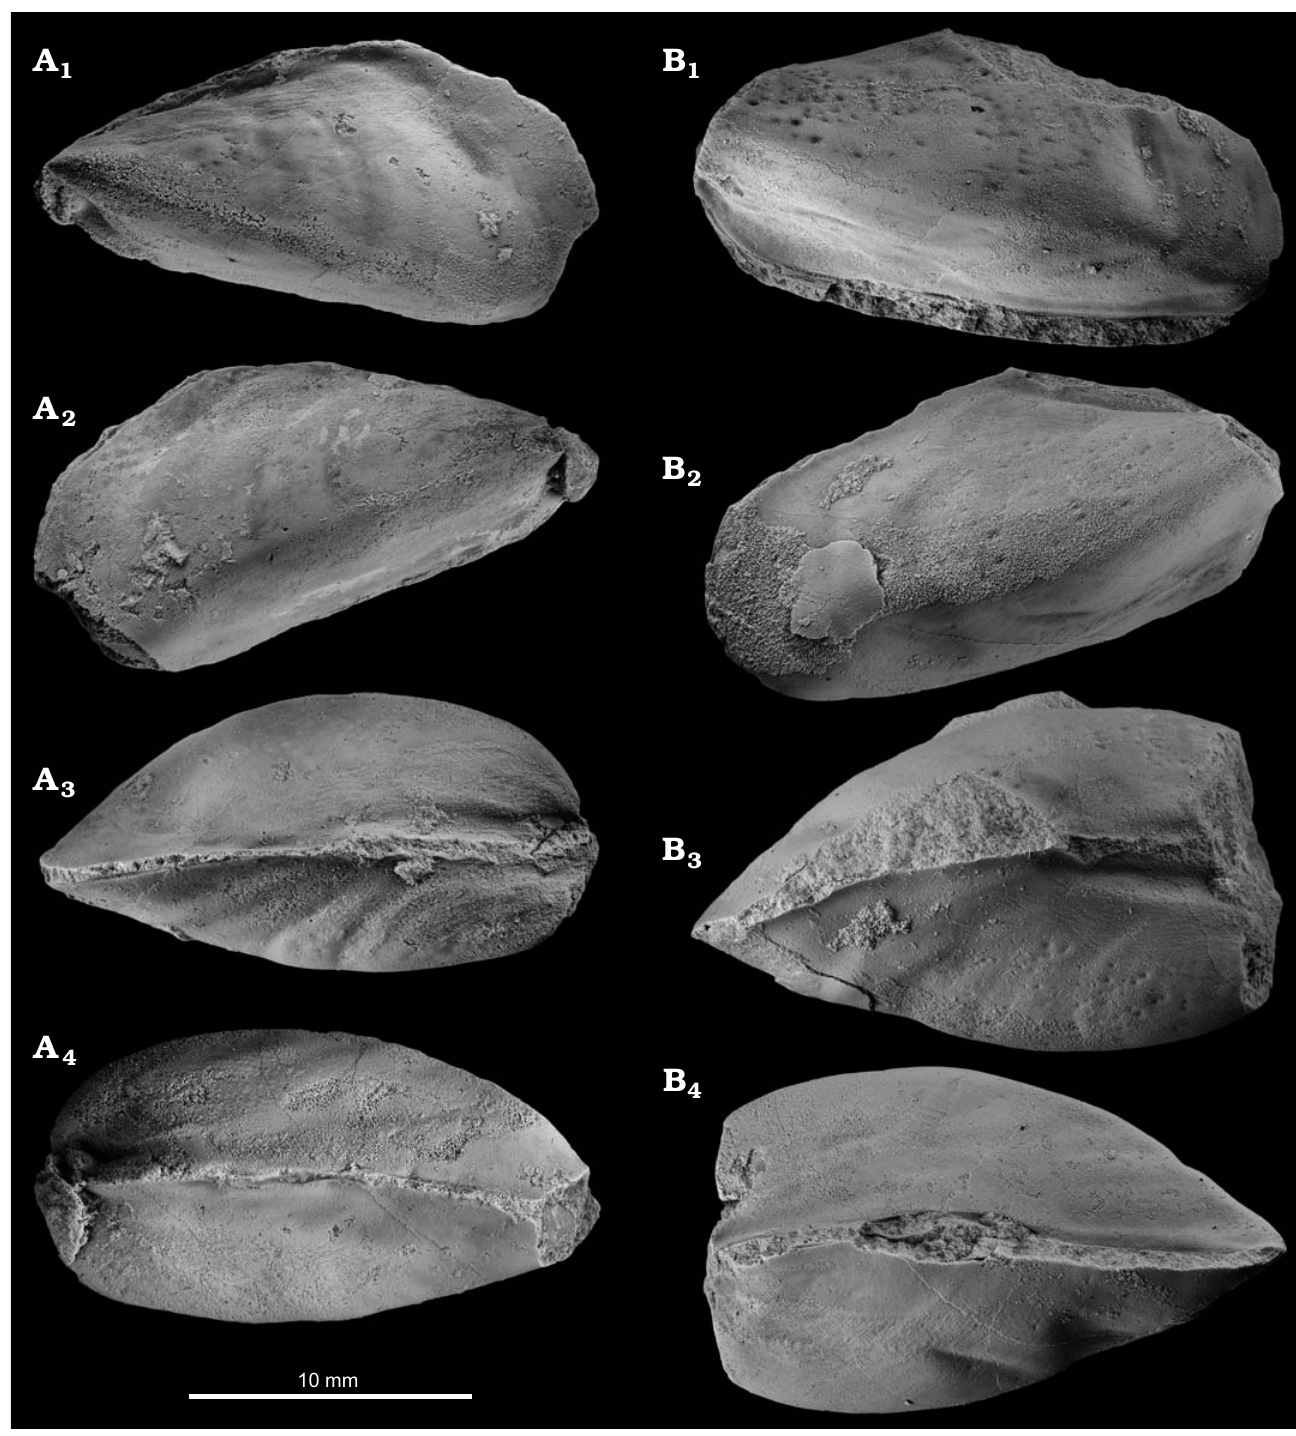
Fig. 5. The kalenterid bivalve Kasimlara kosuni gen. et sp. nov. from the late Carnian, Late Triassic Terziler III seep deposit in southern Turkey. A . Mo184063, internal mold of an articulated specimen; left (A 1 ) and right (A 2 ) valves, dorsal (A 3 ) and ventral (A 4 ) sides, showing the curvature of the shell. B . Mo184064, internal mold of articulated specimen; left (B 1 ) and right (B 2 ) valves, dorsal (B 3 ) and ventral (B 4 ) sides, showing the curvature of the shell; note the strong, healed predation scars on the posterior side of the left valve (B 1 ) and on the posteroventral side of the right valve (B 4